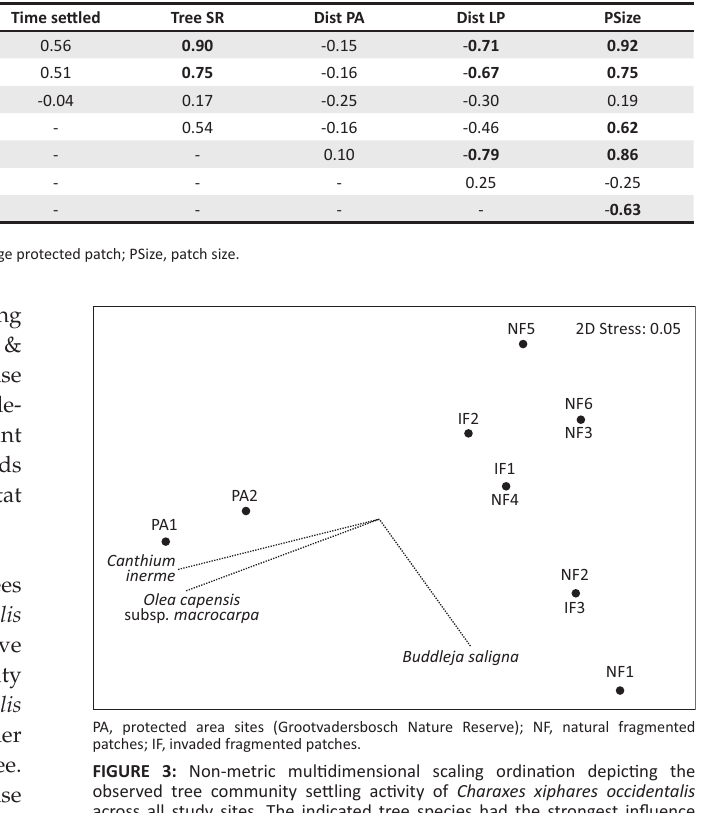
) to compare the relationships between measured environmental variables and behavioural traits s